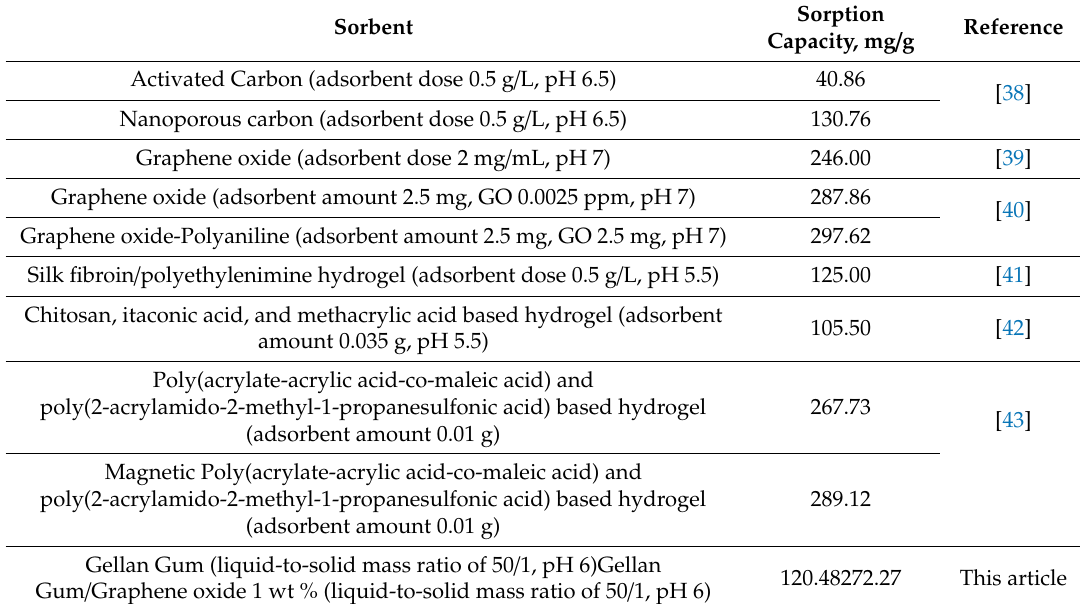
Table 3. Sorption capacity of di ff erent materials for Zn (II). Values were obtained in the best operation